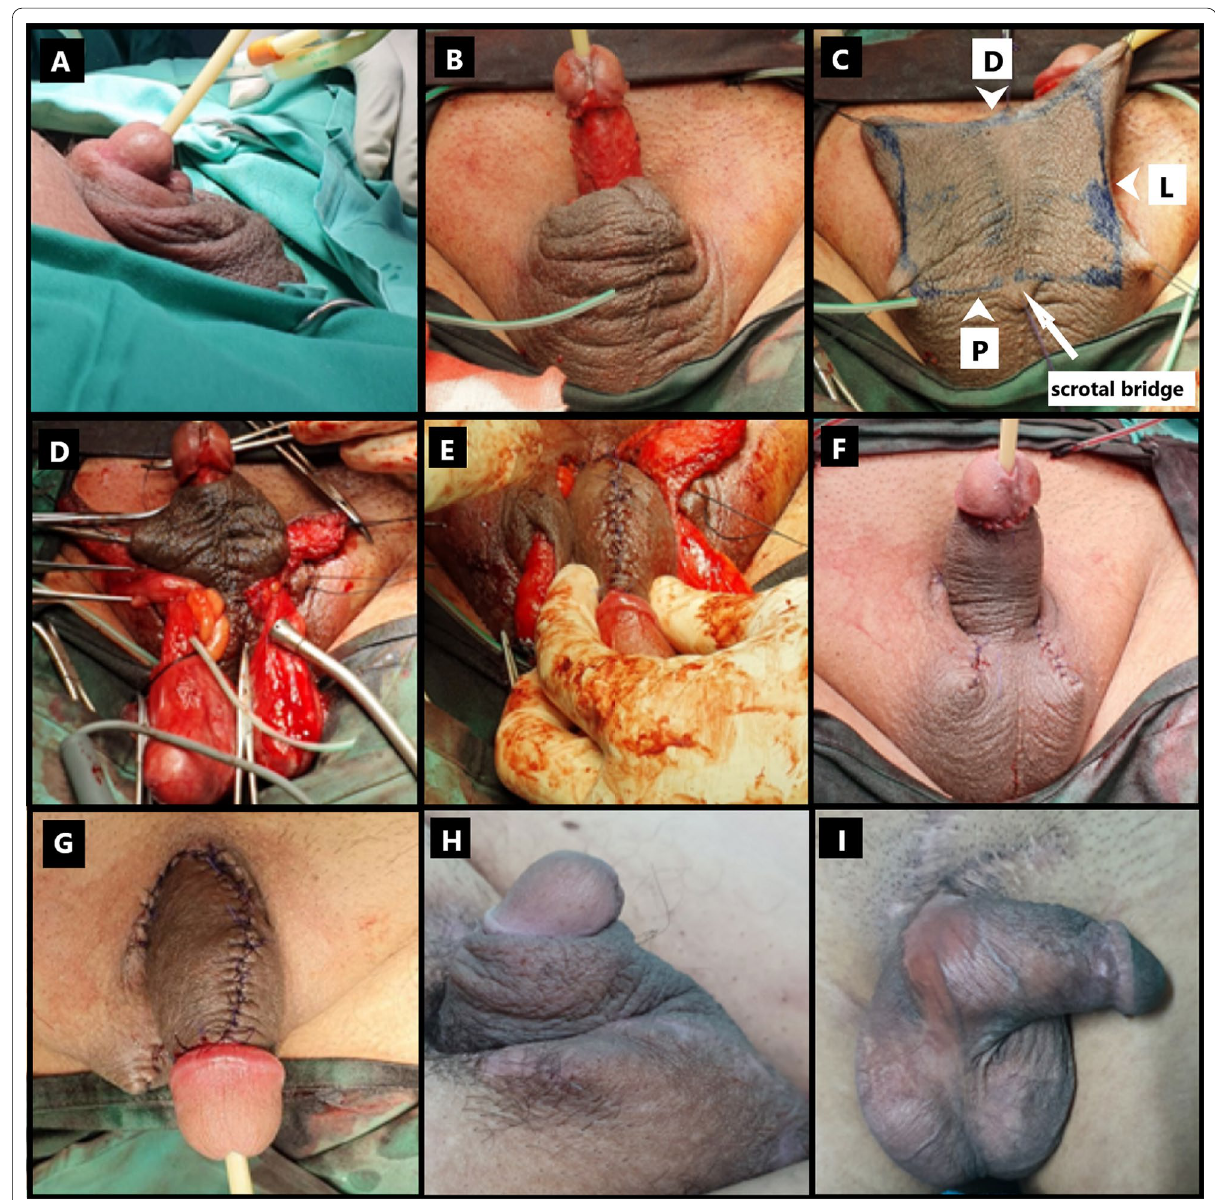
Fig. 1 Performing penile resurfacing surgery for extensive penile paraffinoma using the scrotal bridge flap technique. ( A ) Penile paraffinoma involving the entire penile shaft; ( B ) Radical excision of fibrotic tissue resulting in a denuded penile shaft; ( C ) Scrotal flap markings corresponding to the previously measured penile length [L], circumference of the proximal penile shaft [P], and circumference of the distal penile shaft [D]. A 1-cm scrotal bridge is assigned at the median ventral-inferior raphe; ( D ) The flap is elevated and advanced to cover the penile shaft; ( E ) The flap is wrapped around the penile shaft and sutured dorsally; ( F , G ) Dorsal and ventral views of the immediate result. ( H ) The result after 5 months. ( I ) The result after 1 year in another patient who underwent a similar